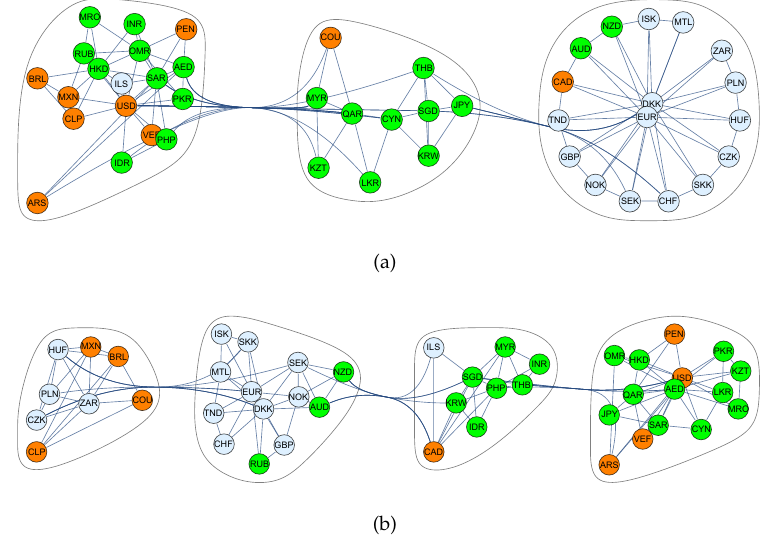
Figure 5. Planar maximally filtered graph (PFMG) for the foreign exchange markets obtained using synchronous correlations during ( a ) the economically calm period and ( b ) crisis period. The currencies are denoted by their three-letter symbols and color-coded according to their geographical locations: green for Asia, light blue for Europe, orange for the Americas. During the calm period, we detect three large clusters. Most distinctive is the European cluster on the right, with the euro and the Danish krone, which is pegged to the euro, at the center. The Asian countries split in two different clusters, with major oil-exporting countries being closely associated with the US dollar which is at the center of its community. The remaining Asian countries form the third cluster. During the crisis, the hierarchy of the euro cluster collapses. The community around the US dollar still contains the oil-exporting countries. It is joined by the Chinese yuan and the Japanese yen. The Brazilian real, Mexican peso and Chilean peso, however, are no longer part of the US dollar-centered community during the crisis